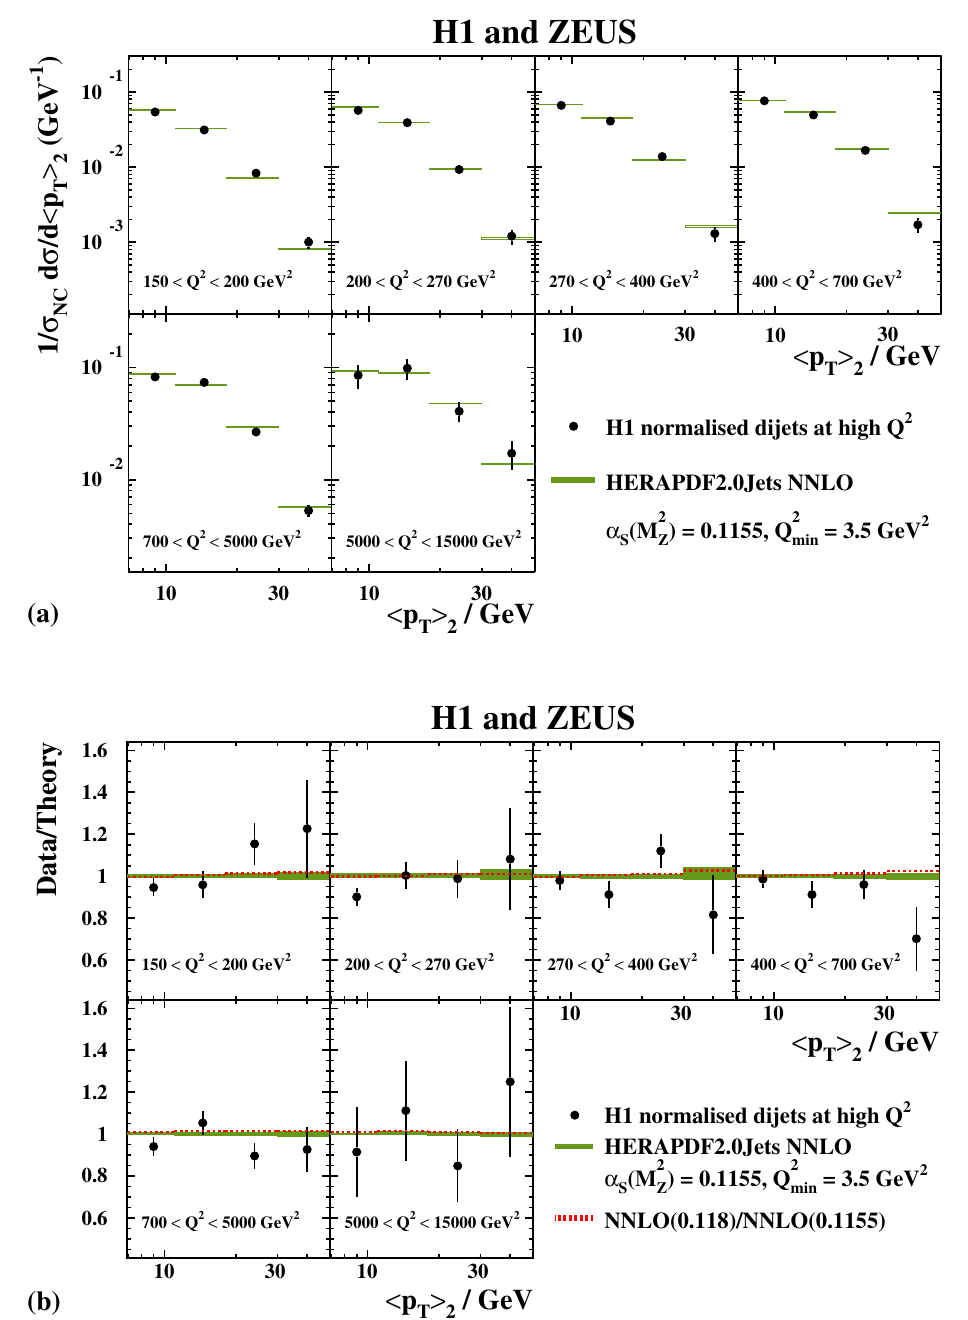
Fig. 18 a Differential dijet-cross-section predictions, d σ/ d (cid:5) p T (cid:6) 2 , based on HERAPDF2.0Jets NNLO with α s ( M 2 of Q 2 between 150 and 15,000GeV 2 compared to H1 data normalised to neutral current (NC) cross sections [13]. The variable (cid:5) p T (cid:6) 2 denotes the average p T of the two jets. Only data used in the fit are shown. b Measured dijet cross sections divided by predictions based on HERA-